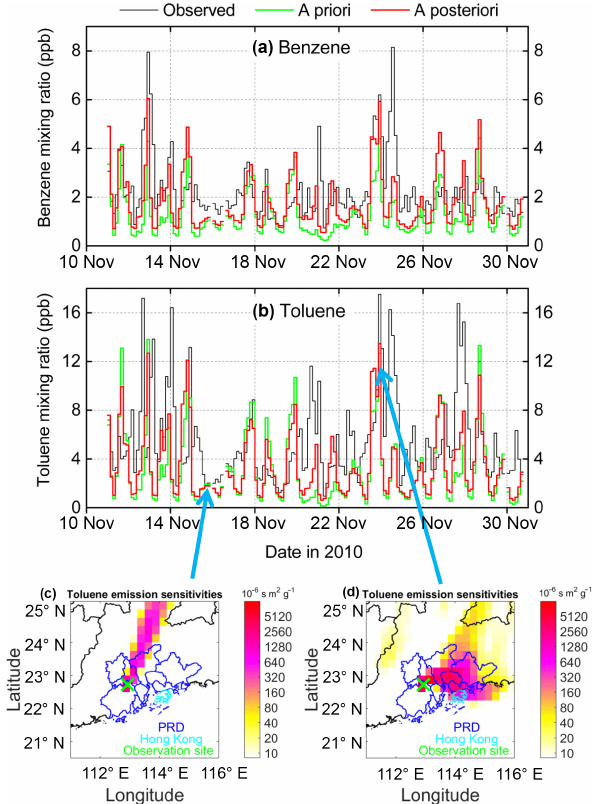
Figure 3. Observed and simulated (a) benzene and (b) toluene mixing ratios at the Heshan site, and two examples of spatial dis- tributions of toluene emission sensitivities at (c) 00:00UTC on 16 November 2010 and (d) 00:00UTC on 24 November 2010.